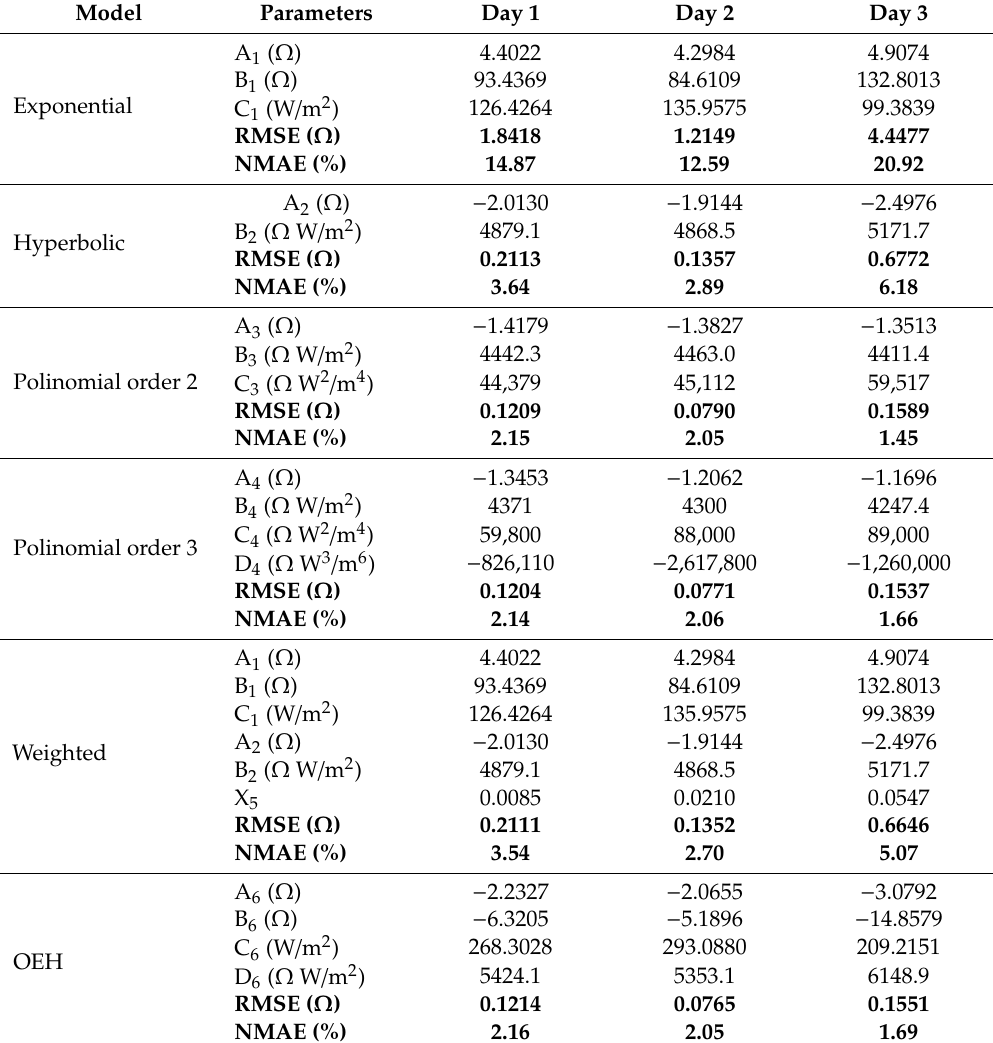
Table 2. Obtained parameters and R MPP fitting